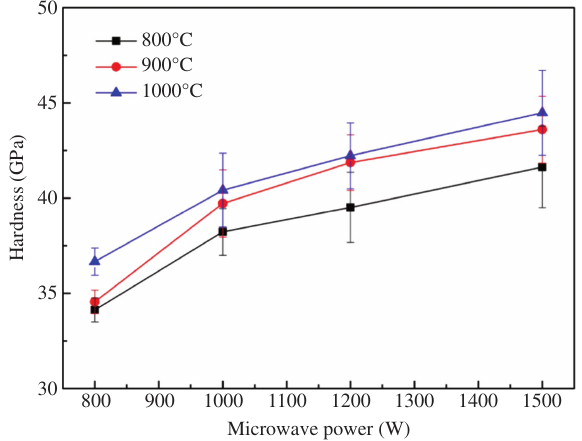
films deposited at the various microwave 2 = 1/2, 1 /BCl 4 3